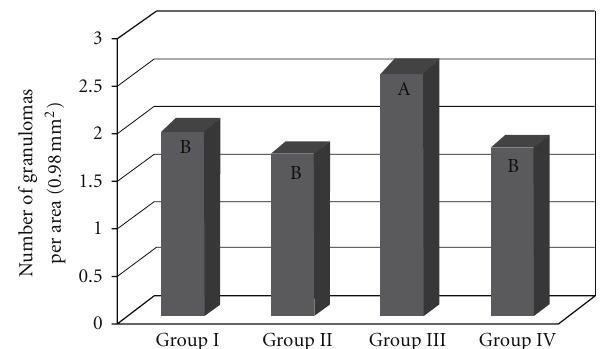
Figure 5: The number of lung granulomas of the mice that were inoculated with eggs of the S. mansoni BH (Group I) or SJ (Group II) strains and of those that were previously infected with the S. mansoni BH strain and inoculated 8 weeks later with eggs from the S. mansoni BH (Group III) or SJ (Group IV) strains. The means with di ff erent letters exhibited a significant di ff erence ( α = 0 . 05).